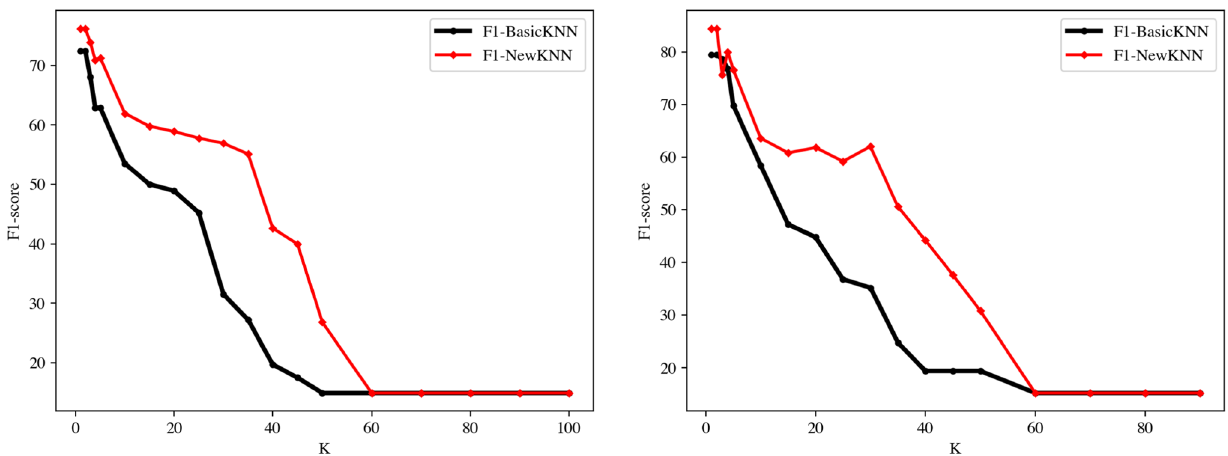
Fig. 4 F1-score evolution for KNN using Jaccard distance with tenfold and fivefold cross-validation on Restaurant